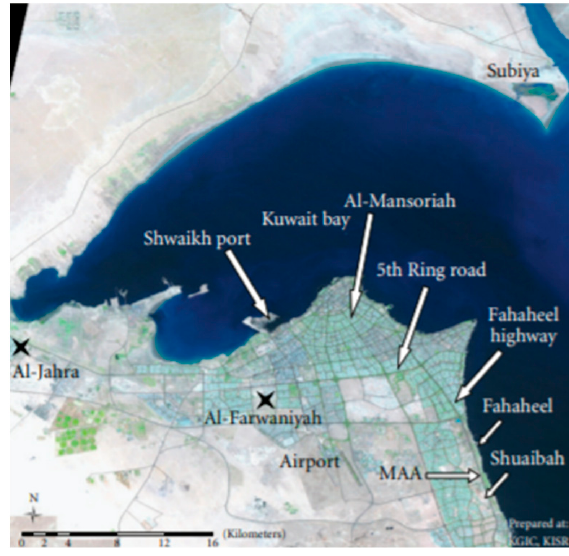
Figure 1. Urban Kuwait map showing main locations [3].